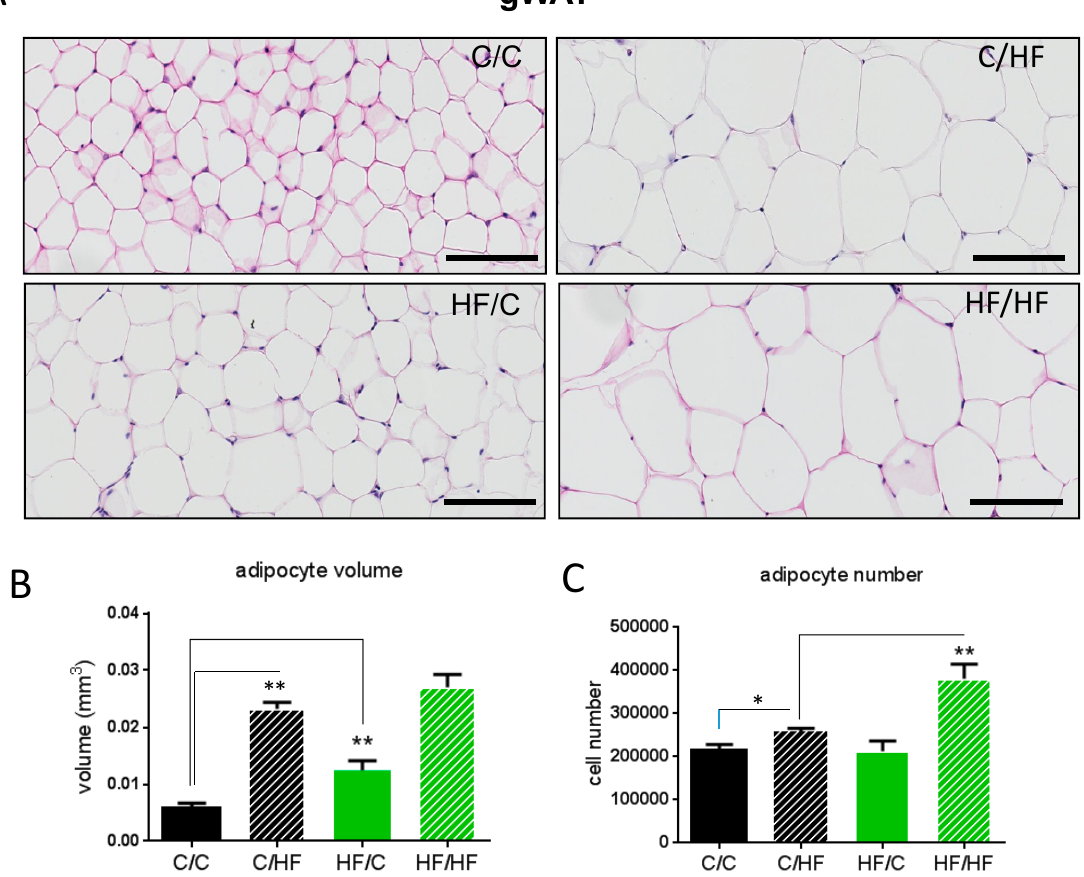
Figure 2. Representative gonadal white adipose tissue (gWAT) histological images (H&E stain) scale bars 50 µ M ( A ), calculated adipocyte volume ( B ) and adipocyte number ( C ) of female chow ( C )- or high-fat (HF)-fed 30-week-old offspring of dams fed a chow ( C ) or HF diet for 6 weeks prior to pregnancy and during pregnancy and lactation. N = 5. * p < 0.05, ** p <